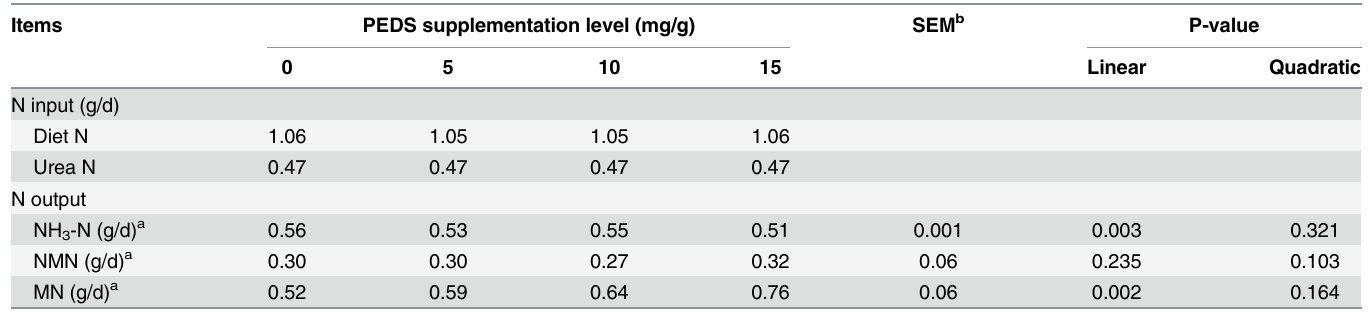
Table 5. The effects of PEDS on nitrogen metabolism and MOEEF in continuous culture.